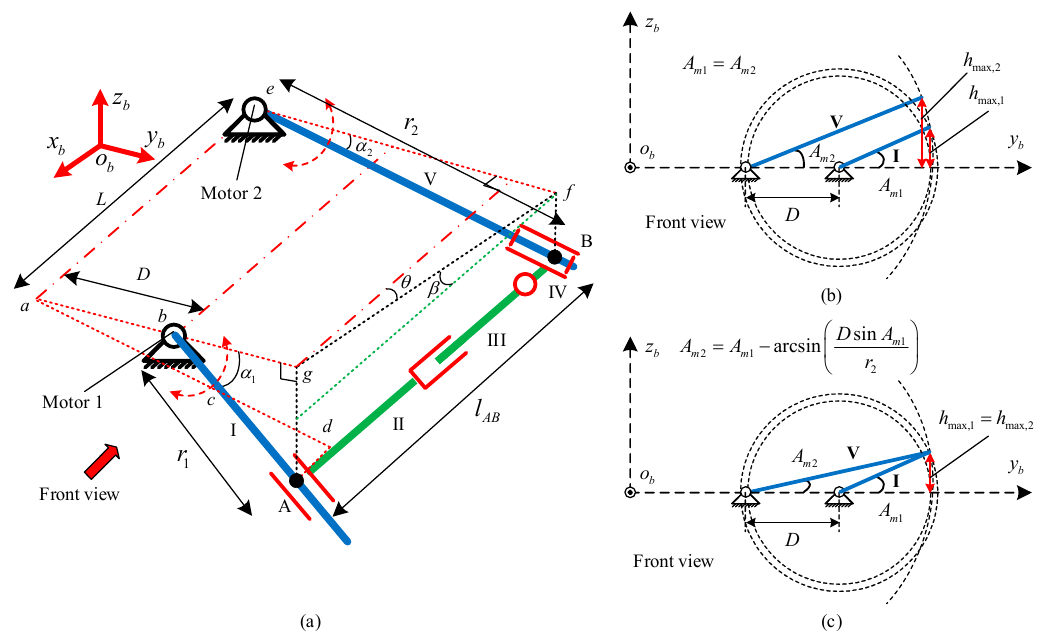
Figure 3. Geometric relationship of the bionic pectoral fin mechanism. ( a ) Schematic diagram of bionic pectoral fins. ( b ) Geometric relationship between the driving components without compensation. ( c ) Geometric relationship between the driving components after compensation. Equation (1) contains all motion parameters, A mi represents the amplitude, which is the maximum angle at which components I and V deviate from the x b o b y b plane, ω i is the rotation angular velocity of components I and V, where its magnitude is equal to 2 π f , and f is the frequency. In this research, the frequencies of driven motors are equal to each other and can be written as ω i = ω . ϕ i represents the phase of the two components. δ i represents the bias angle deviating from the x b o b y b plane. When the